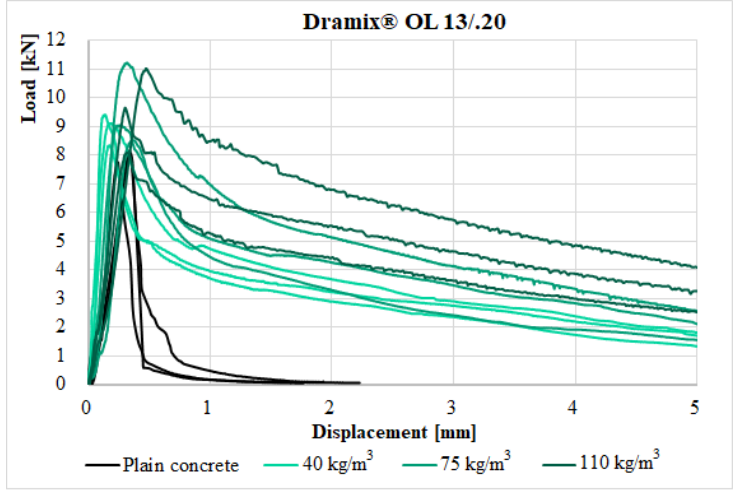
Figure 16. Load–displacement diagram for fiber-reinforced concrete with hooked fibers and plain concrete.